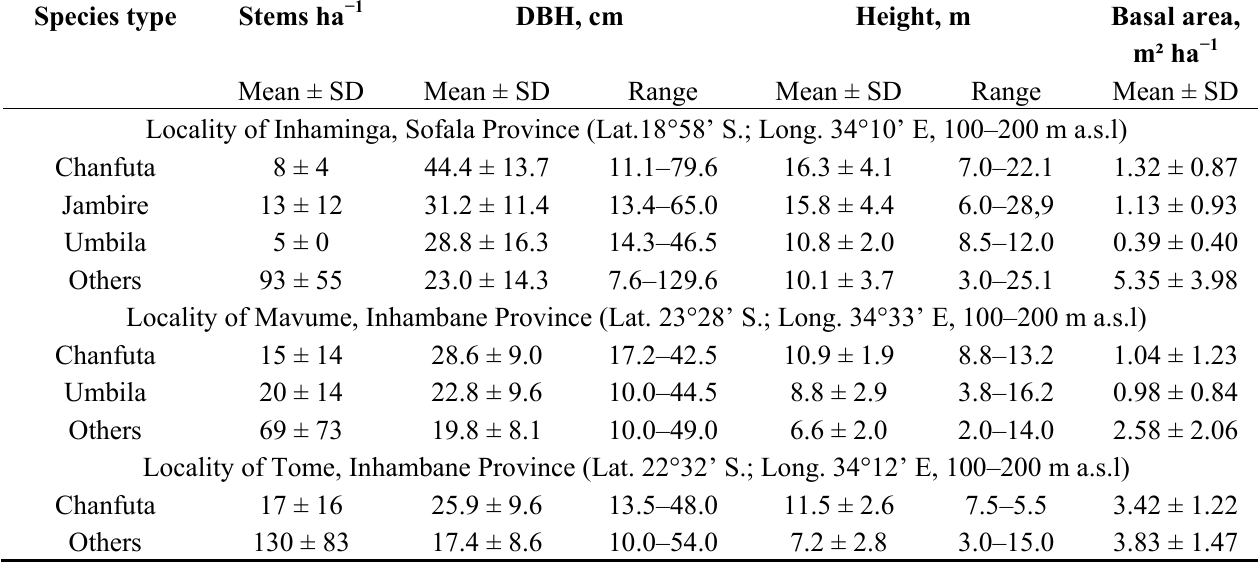
Table 1. Characterization of species growing in stands at three visited localities. Species